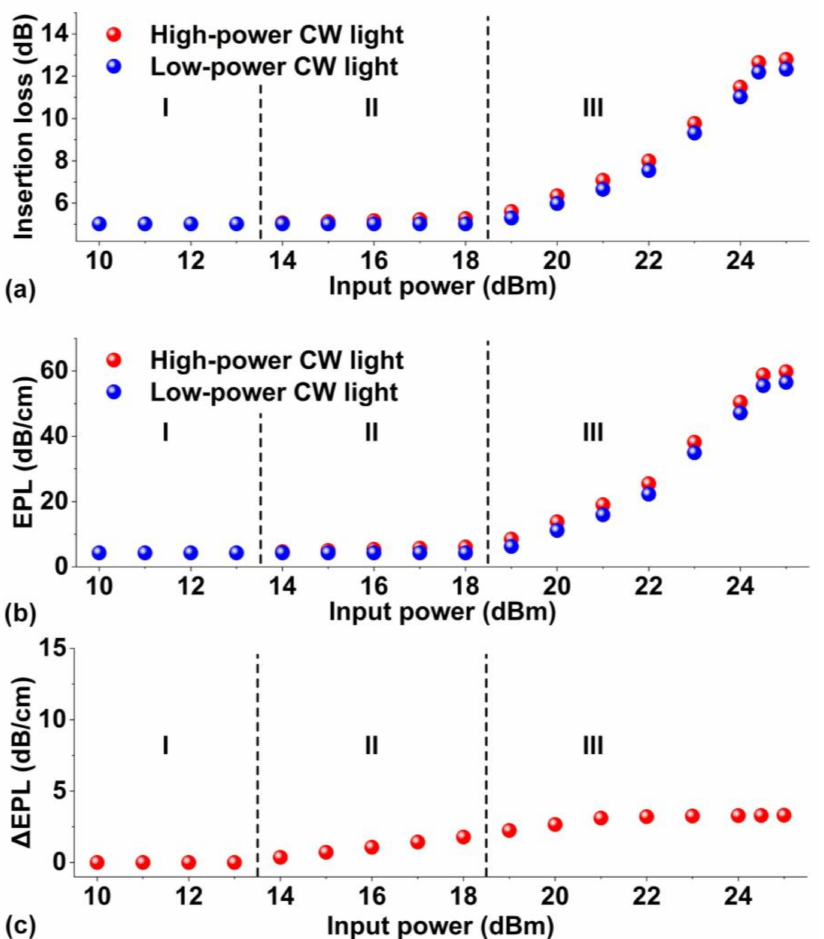
Figure 4. Experimental results for characterizing PTT of the hybrid waveguide coated with 2 layers of GO. ( a ) Insertion loss of the hybrid waveguide versus the input power of the high-power light source. The red dots show the loss of the high-power CW light source, and the blue dots show the loss measured with a low-power CW light source after exposure at the power level indicated on the X-axis. ( b ) GO-induced excess propagation loss ( EPL ) versus input power of the high-power light source. The red and blue dots show the results corresponding to the red and blue dots in ( a ), respectively. ( c ) ∆ EPL extracted from ( b ) showing the difference between the red and blue dots.